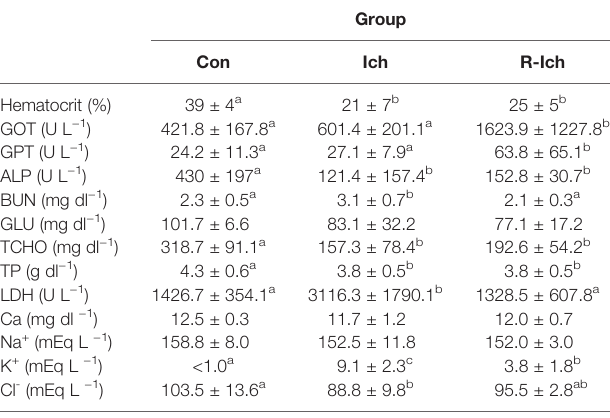
TABLE 1 | Hematological and serological changes among groups (Control, Con; I. multi fi llis infected group, Ich; and I. multi fi liis recovery group,